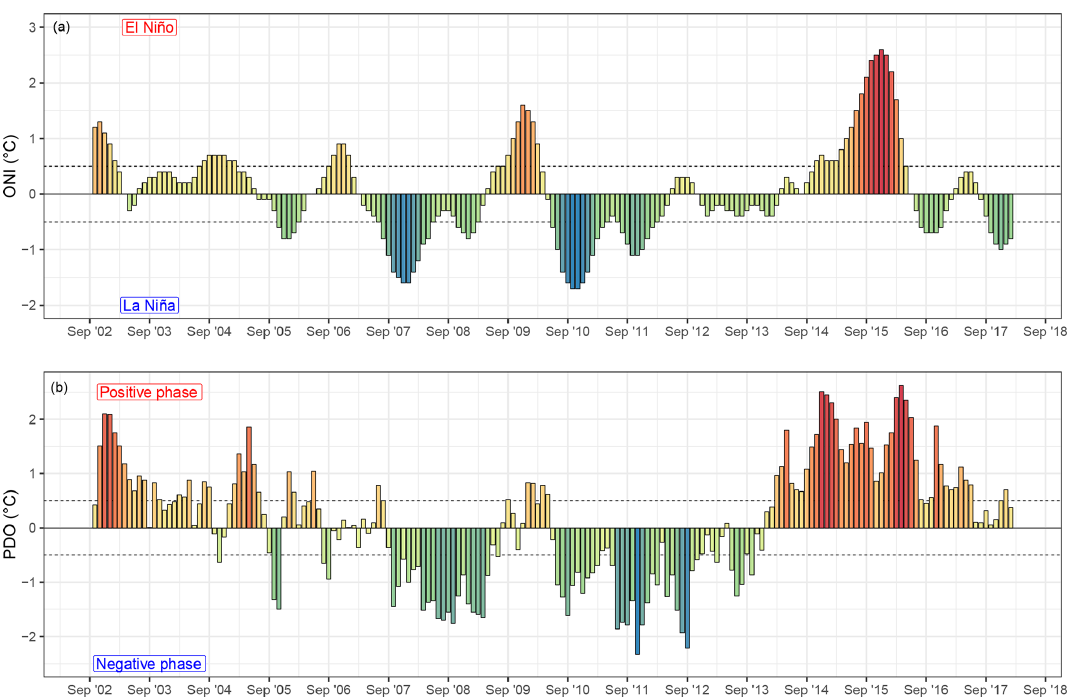
Figure 2. Monthly values of the Oceanic Niño Index (ONI; a ; National Oceanic and Atmospheric Adminsitration, 2019) and Pacific Decadal Oscillation (PDO; b ; Joint Institute for the Study of the Atmosphere and Ocean, 2019) over time (2002–2018). ONI and PDO phases are generally considered in phase when anomalies are over 0.5 ◦ C or under − 0 . 5 ◦ C (dashed grey lines) for 5 consecutive months; the ± 0 . 5 ◦ C line is marked as a dashed grey